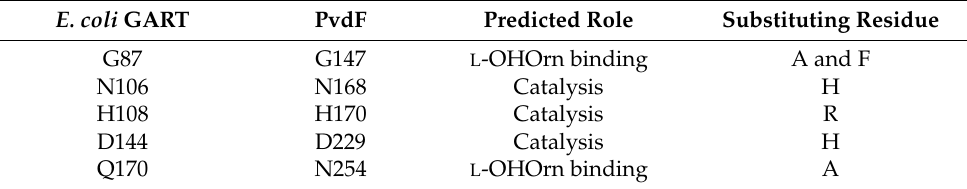
Abbreviations: GART, glycinamide ribonucleotide transformylase; L-OHOrn,